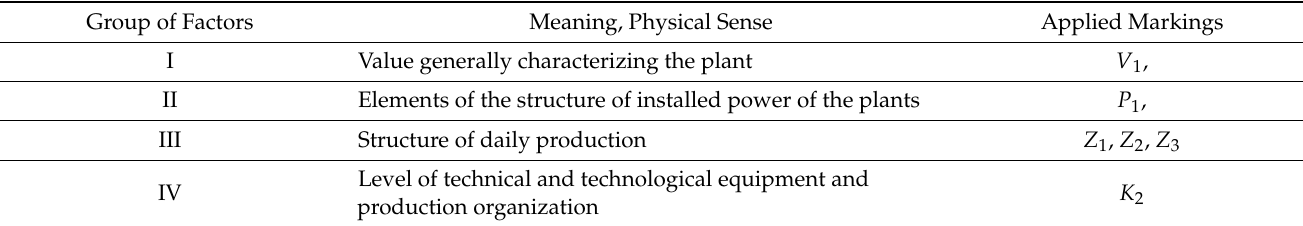
Table 2. Factors affecting water consumption in production